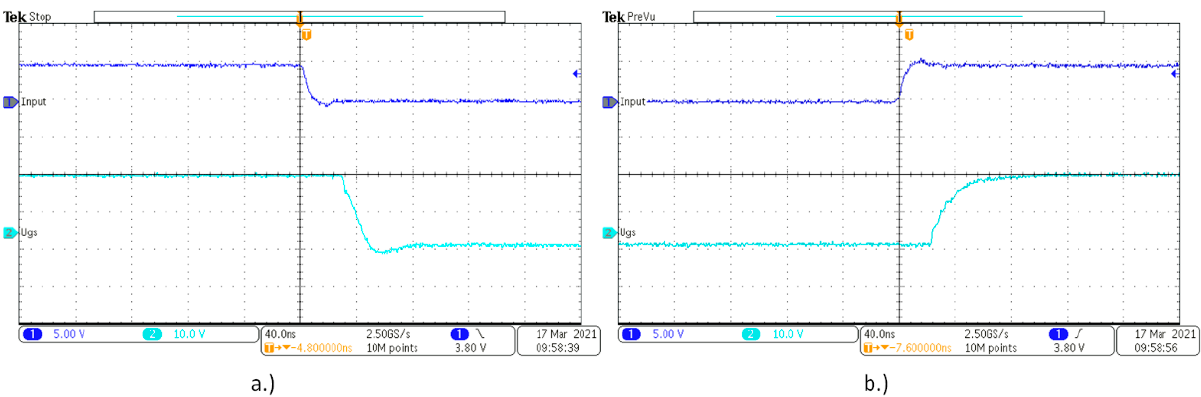
values correspond to the values in the driver datasheet.